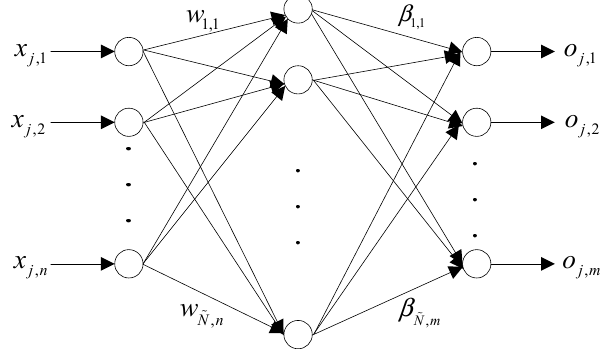
Figure 1. Architecture of the extreme learning machine (ELM) network.